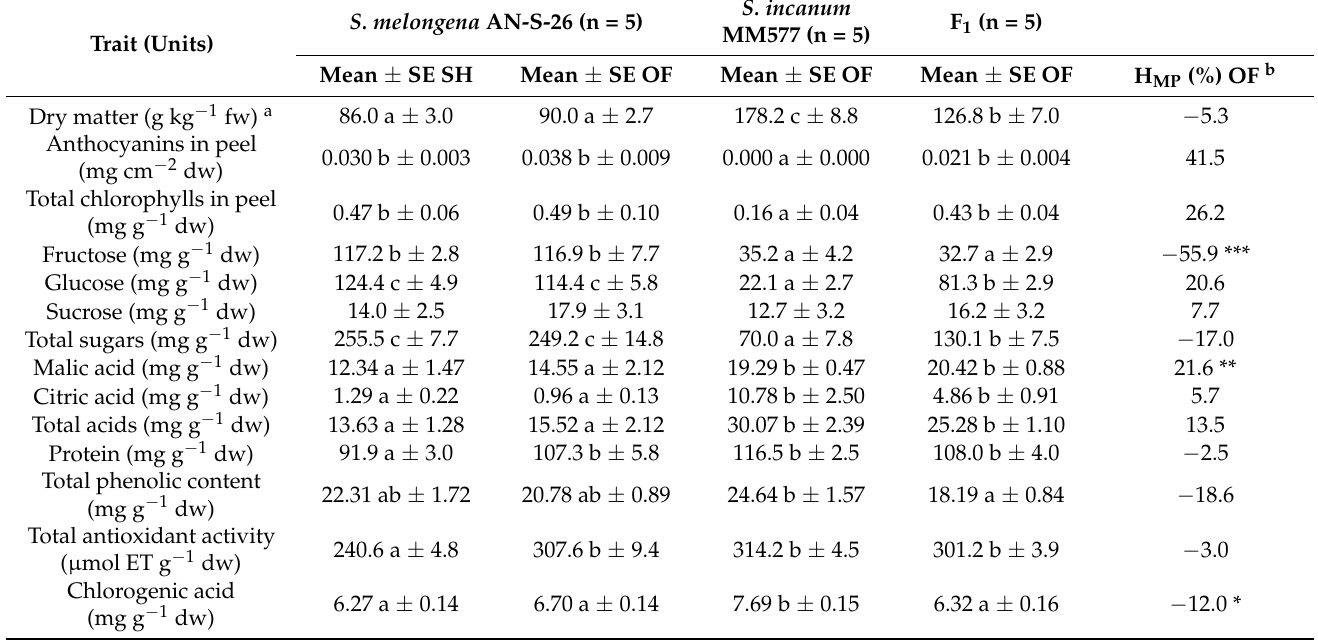
Table 1. Mean values and standard error (SE) of each trait were analyzed for the recipient parent ( S. melongena ; AN-S-26; n = 5) under open field (OF) and screenhouse (SH), and for the wild parent ( S. incanum ; MM577; n = 5) and the F 1 (n = 5) under OF. Units are expressed on a dry weight (dw) basis except for dry matter. The hybrid mid-parent heterosis (HMP) calculated under OF with its significance is also